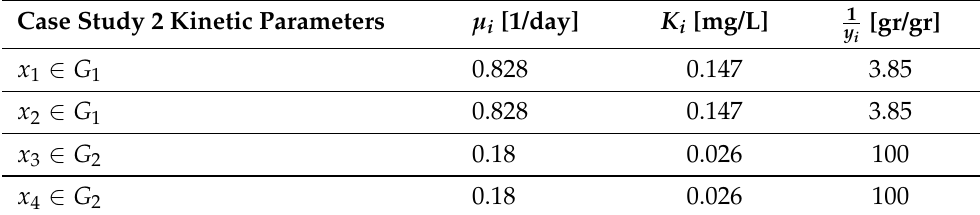
Table 3. Kinetic parameters of model (3) from Dumont et al. [16].